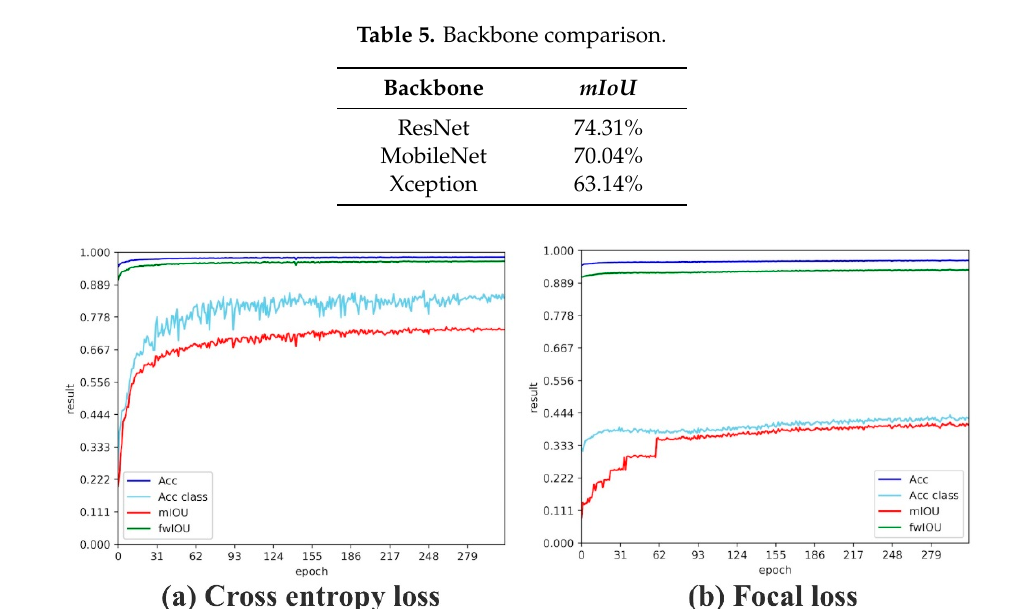
Figure 9. Result of segmentation by different loss function.